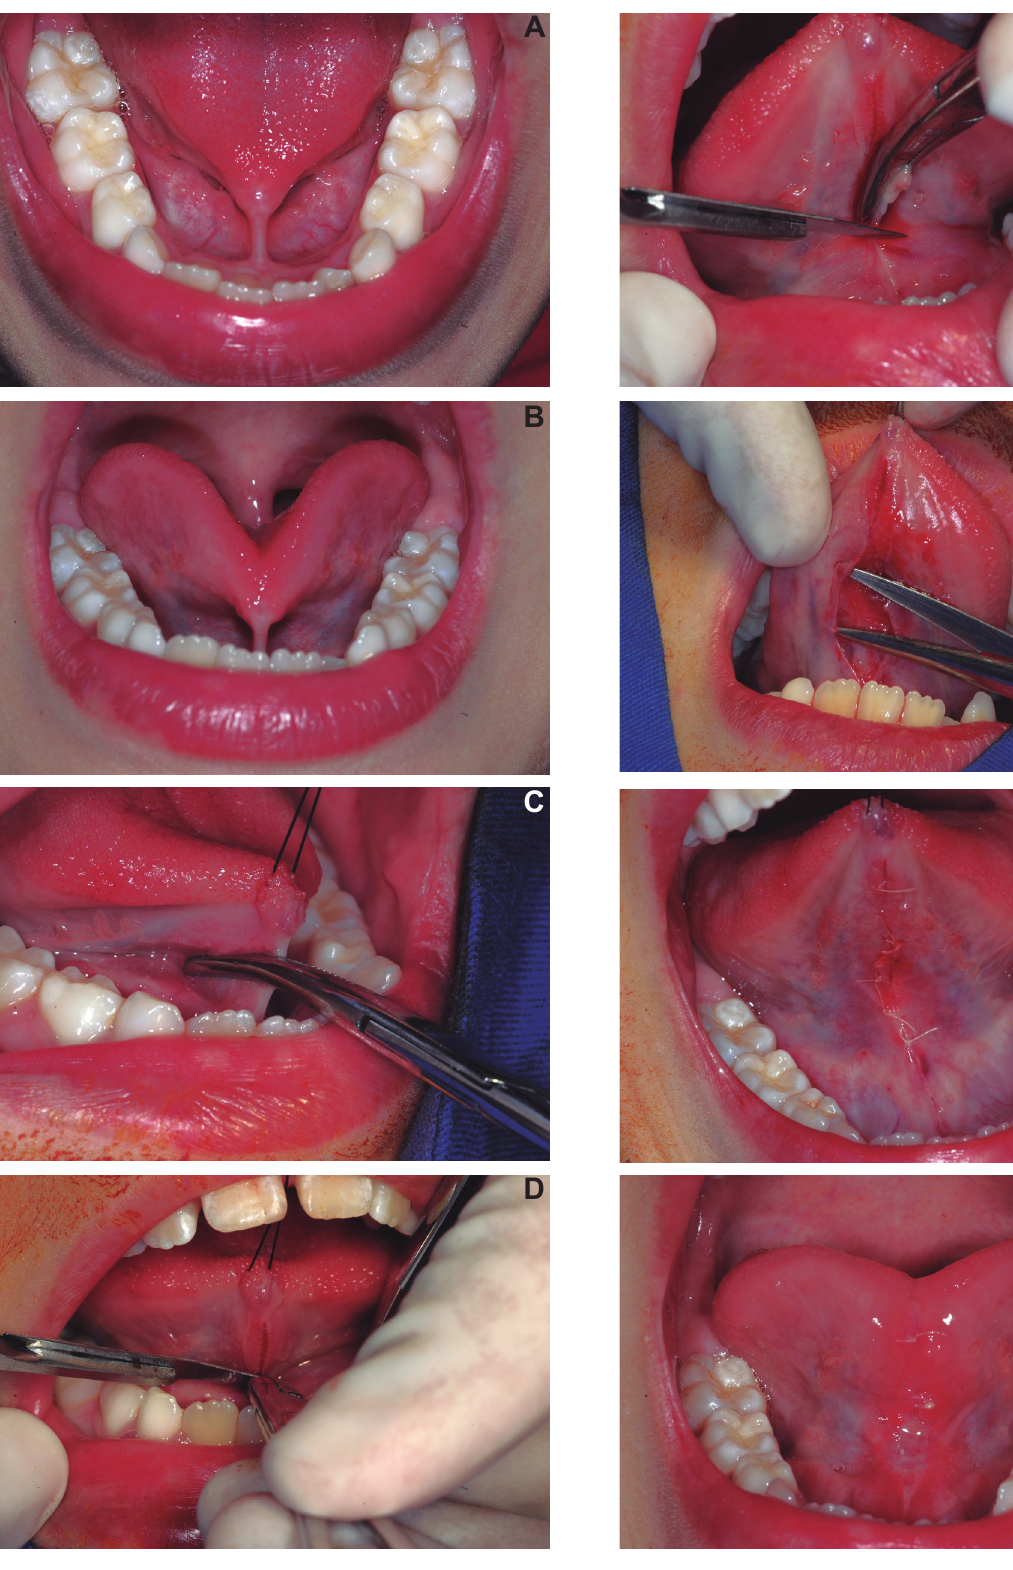
Figure 2- Frenectomy with use of one hemostat. A) Thick and short lingual frenulum with anterior insertion. B) Restricted central tongue tip elevation caused by abnormal attachment of the base of the tongue. C) Frenulum being held with a small curved hemostat with the convex curve facing the ventral surface of the tongue. D) First incision following the curvature of the hemostat, cutting through the upper aspect of the frenulum. E) Second incision at the lower aspect of the frenulum. F) Wound edges being dissected with the tips of blunt-ended scissors. G) Absorbable sutures placed over the wound.